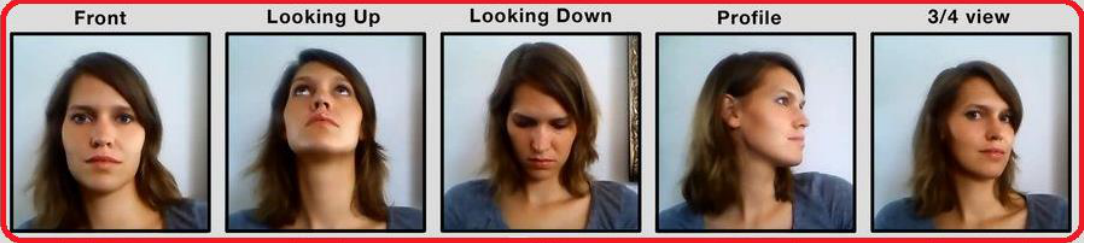
Figure 34. Change of pose. The original image is on the left.